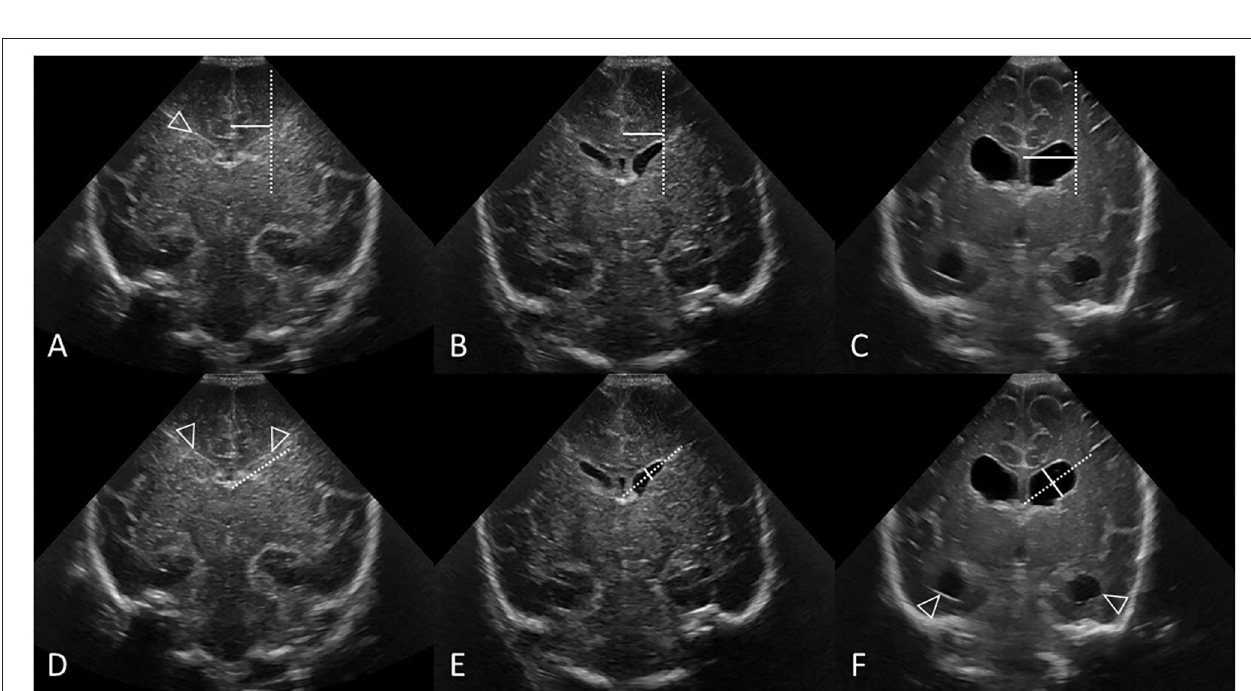
FIGURE 7 | passive in origin and resulting from tissue volume loss. (J–L) Grade 4 WMI. Ultrasound scan in a preterm infant (GA 25 weeks) with significant WMI. (J) Coronal scan 5 days after birth, at the level of the body of the lateral ventricles, shows patchy areas of echodensity (arrows) in the periventricular frontoparietal white matter. No IVH. (K,L) Coronal and right parasagittal scans 3 weeks later show evolution of the WMI with extensive cystic lesions extending from the frontal to the posterior parietal white matter. The progression of WMI could be recognized thanks to serial cUS exams as its severity was not expected by the limited